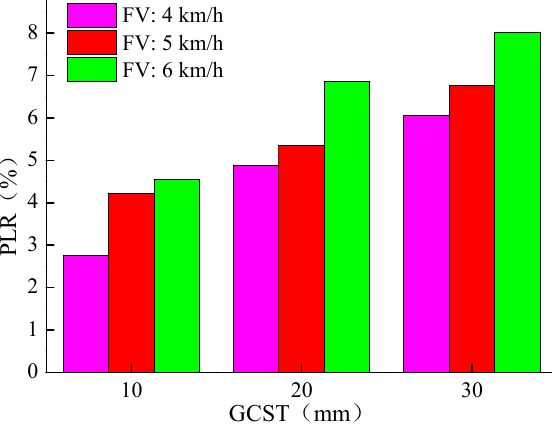
Figure 8. Experimental results of PLR.